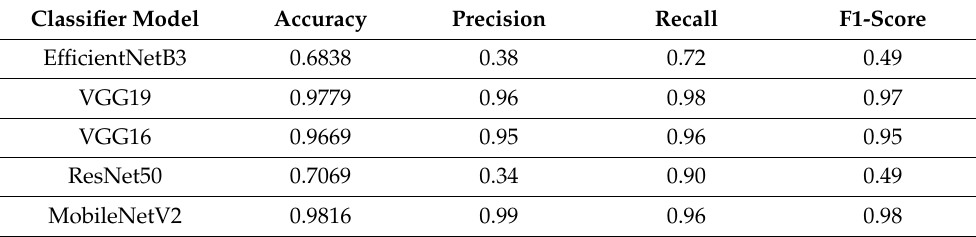
Table 6. Performance of the classifier